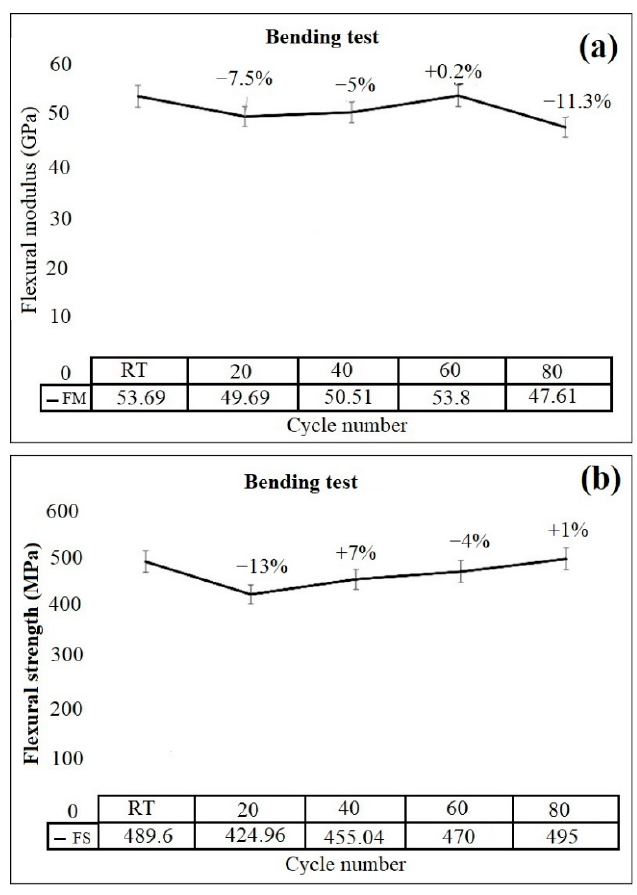
Figure 9. Bending test results of RT and thermal exposure CFRP composites, ( a ) flexural modulus, ( b ) flexural strength.